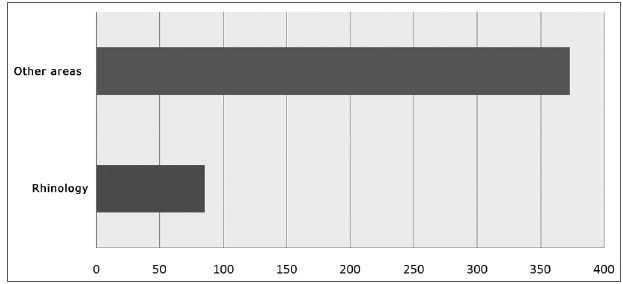
Figure 2. Number of papers published in the Brazilian Journal of